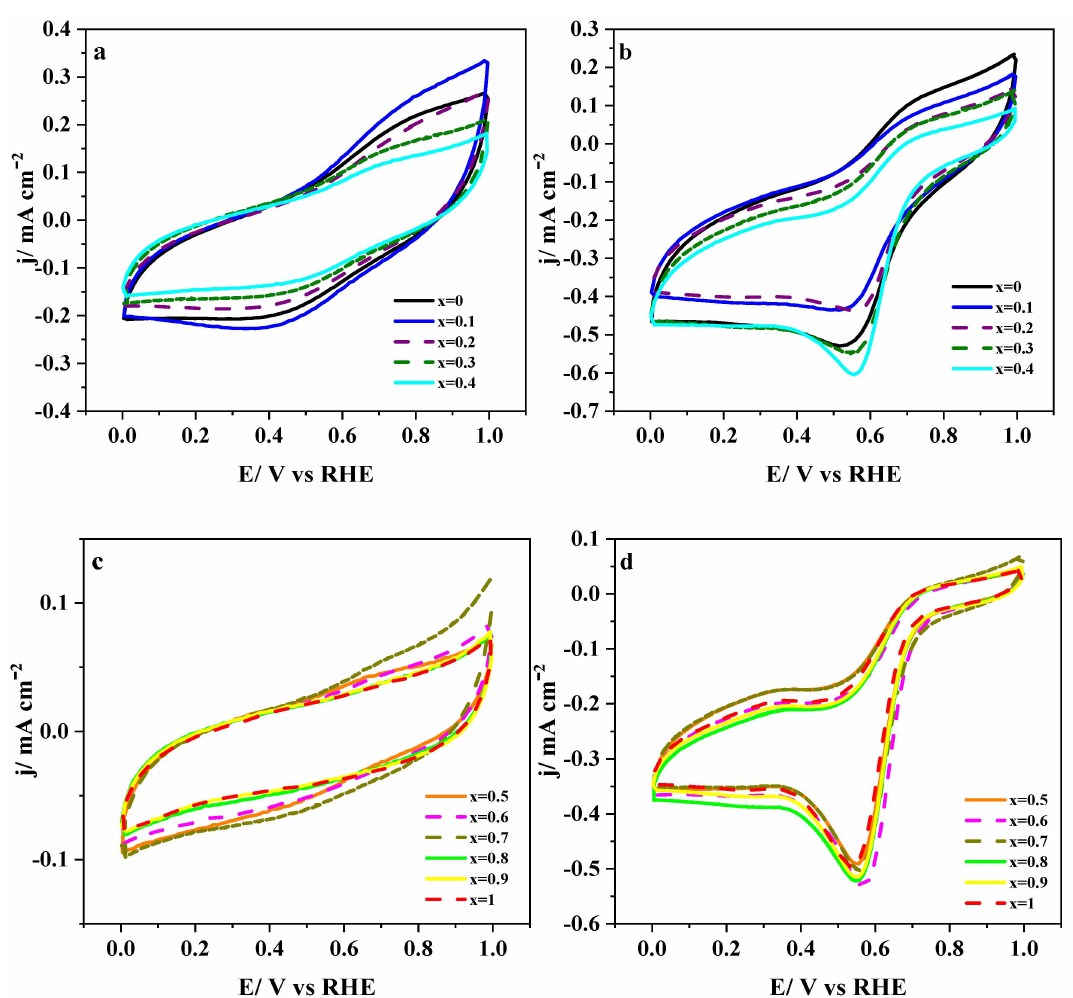
Figure 1. Cyclic voltammograms of LaMn 1 − x Co x O 3 perovskites deposited on glassy carbon substrates in 0.1 M KOH medium saturated with either N 2 ( a , c ) or O 2 ( b , d ). Scan rate: 50 mV /